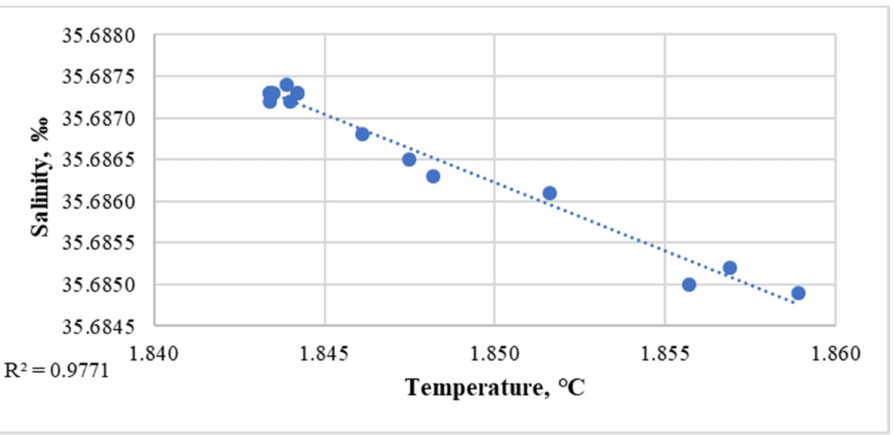
Figure 5. Salinity/temperature regression line for the bottom water layer at a depth of 2835–2850 m. Source: Irina 1, Logachev field.